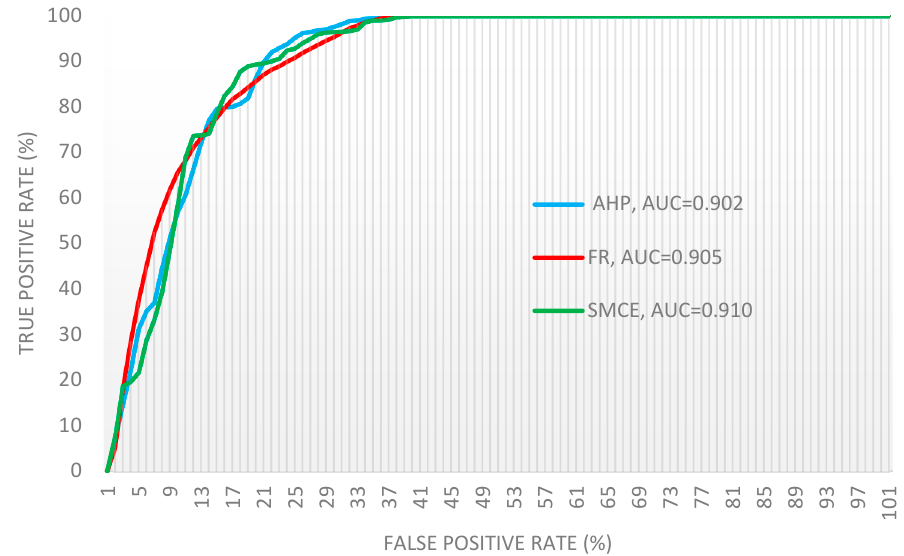
Figure 6. Receiver operating characteristics (ROC) representing quality method success rate curves for the three methods.